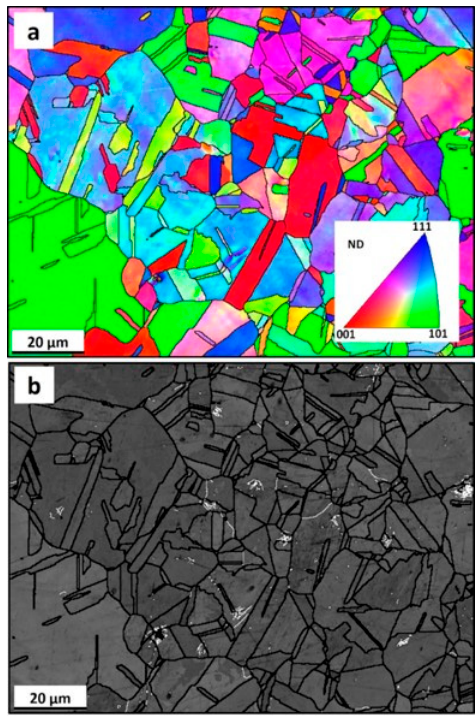
Figure 5. ( a ) Inverse pole figure (IPF) coloring maps and ( b ) band contrast maps with the angle boundaries superimposed for as annealed pure Cu. IPF coloring triangle is shown in ( a ), red: [001]; blue; [111] and green: [101] (for interpretation of the references to color in this figure legend, the reader is referred to the web version of the article.).